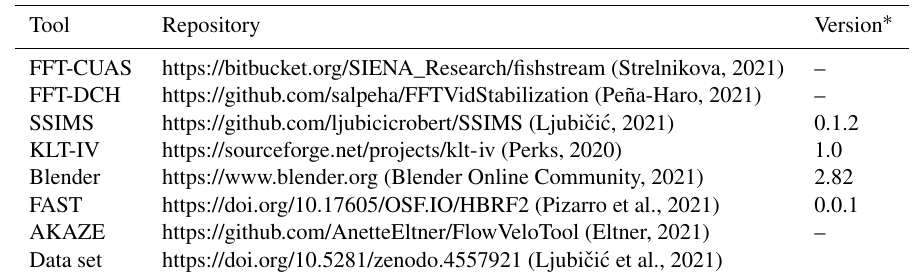
Table A3. Locations of repositories for the stabilisation tools with versions used in this study (as of 21 February 2021), along with the location of the data set containing unstabilised and stabilised frames from all three case